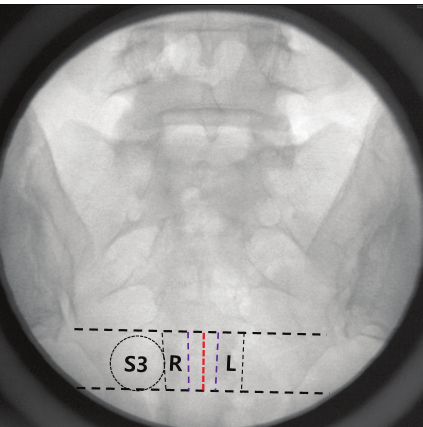
Figure 1: Diagram of the needle tip positions used in this study. S3: ventral foramen of S3, R: needle tip position when injecting in the right side, L: needle tip position when injecting in the left side, red dotted line: needle tip position of